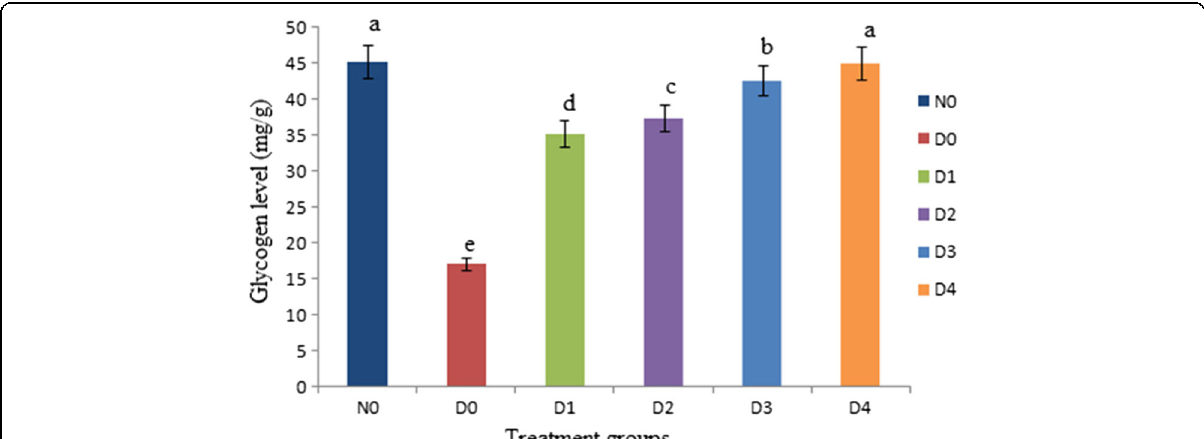
Fig. 5 Effect of Stevia aqueous extract on the glycogen level of the rats. Results are expressed as concentration of glycogen levels of diabetic and non-diabetic rats (mean ± standard deviation (SD). n = 10). a, b, c, d represent significant difference (P < 0.05) in insulin levels treatment wise. The glycogen levels of diabetic rats (D 1 , D 2 , D 3 and D 4 ) received stevia aqueous extract in different concentrations (200, 300, 400 and 500 ppm) respectively significantly (P < 0.05) increased as compared diabetic (D 0 ) control groups and near to N